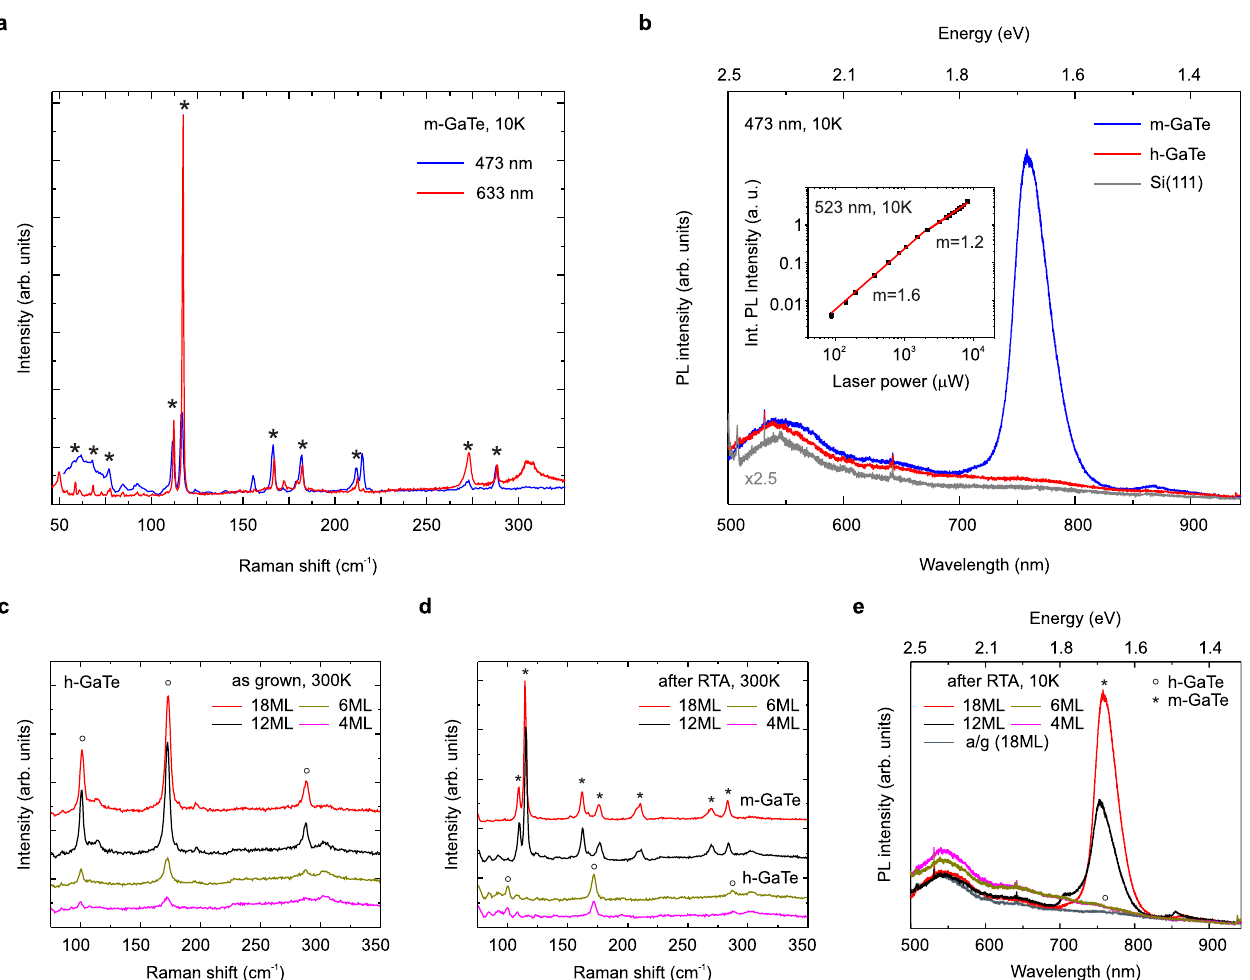
Fig. 5 h-GaTe to m-GaTe phase transformation and phase stability as a function of fi lm thickness. a Low-temperature Raman spectra of 18 ML h-GaTe transformed into m-GaTe after RTA at 550 ∘ C for 30 min. The laser excitations are 473 nm and 632.8 nm. b Low-temperature PL spectra from Si substrate (gray), 18 ML GaTe in the as-grown h-GaTe (red) and m-GaTe after RTA (blue). The inset shows the power dependence of the PL peak at 1.635 eV measured with 532 nm laser excitation wavelength at 10 K with superlinear slope (m) of the excitonic recombination and saturation of the defect-related channel at higher power. c , d Raman spectra of h-GaTe as-grown and after RTA, respectively, for 4, 6, 12, 18 layers. The vibrational modes from h-GaTe and m-GaTe are highlighted with circles and stars, respectively. e Low- temperature PL spectra of h-GaTe fi lms after RTA compared with the as-grown (a/g) 18 ML h-GaTe. Both Raman and PL are excited with 473 nm laser. In order to preserve the material integrity and to protect it from oxidation, all the samples have been capped with Si 3 N 4 before